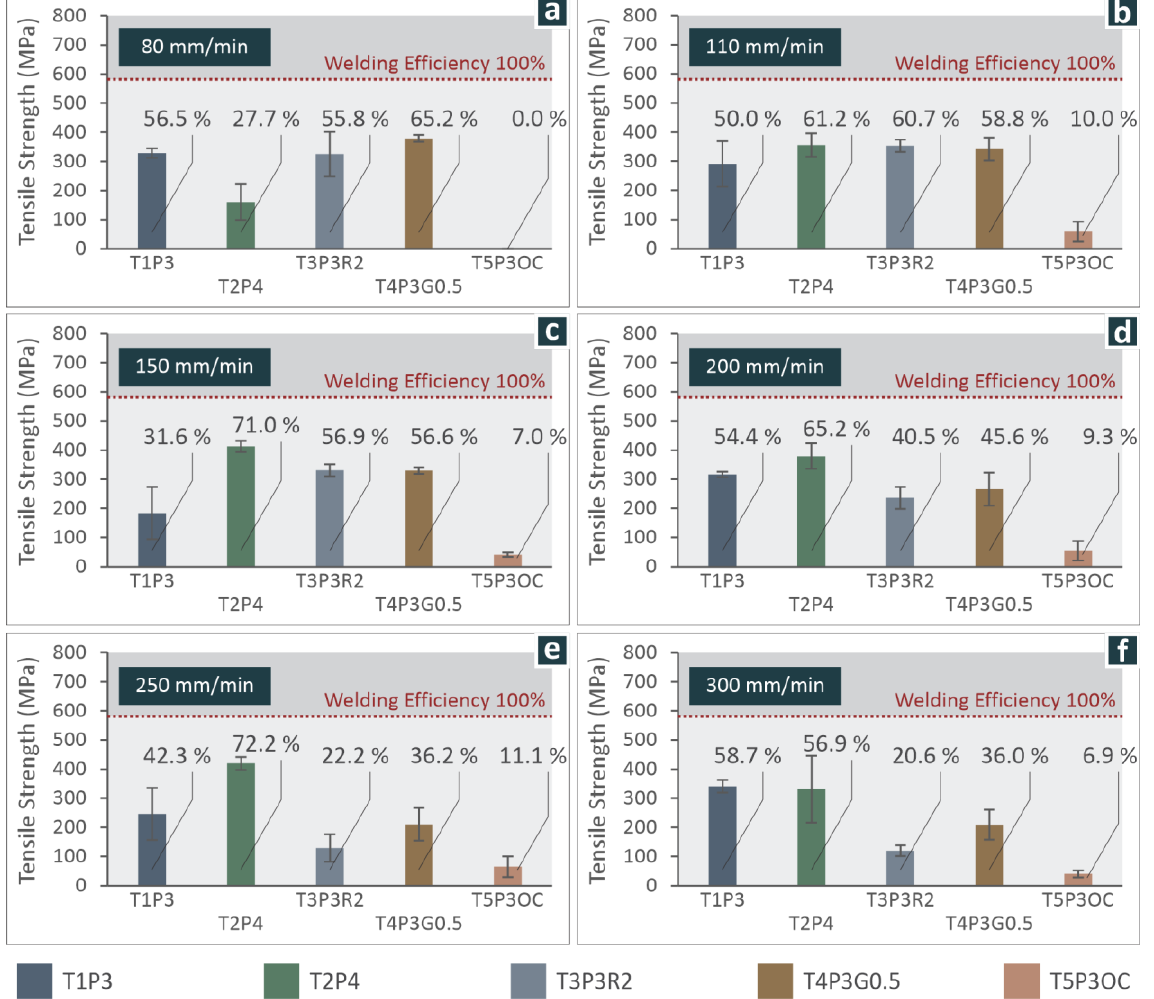
Figure 6. Average tensile strength at welding speeds of ( a ) 80 mm/min, ( b ) 110 mm/min, ( c ) 150 mm/min, ( d ) 200 mm/min, ( e ) 250 mm/min, and ( f ) 300 mm/min. The welding efficiency is noted.